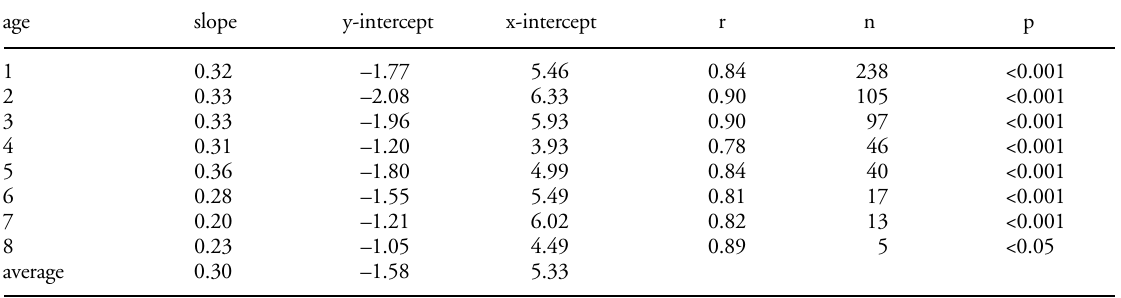
Table 1. Linear regressions and correlation coefficients between shoot length (independent variable) and number of flowers for plants of the same age (n is the number of individuals). Data on Epipactis albensis from 1979 to 1993 collected by Rydlo (1995). age slope y-intercept